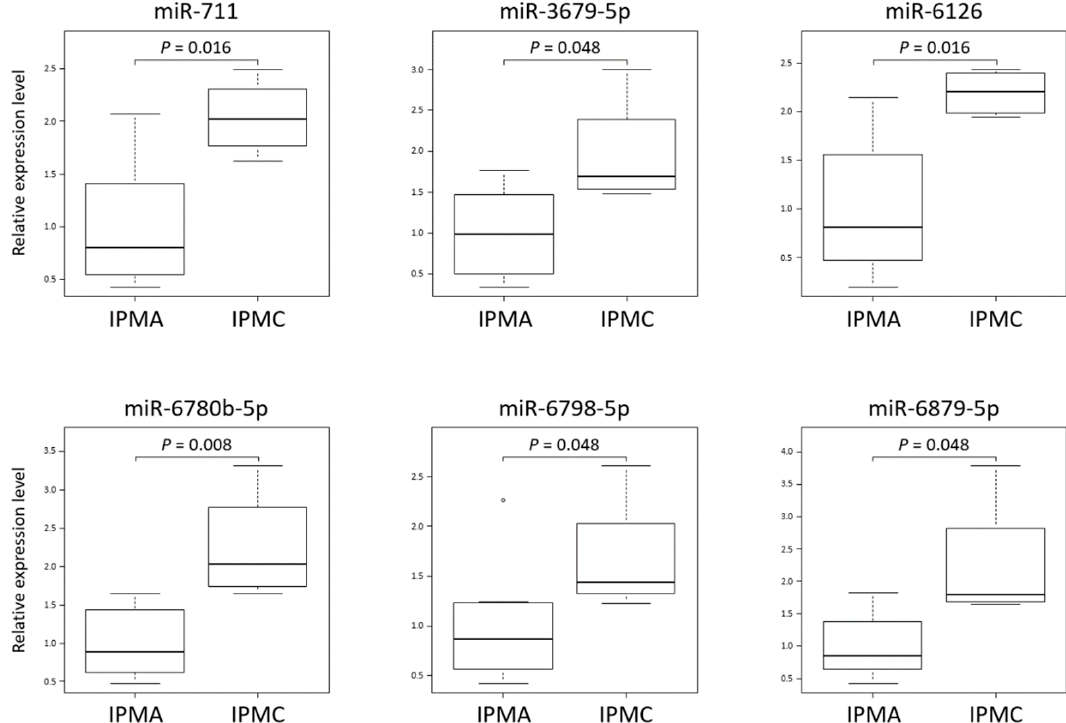
Figure 2. Comprehensive analysis of miRNA expression in cyst fluid of IPMN and comparing IPMA with IPMC. RNA was extracted from IPMN cyst fluid and labeled. Then, RNAs were hybridized and fluorescent signals were scanned as described in Materials and Methods. A relative expression level of a given miRNA was calculated by comparing the signal intensities of the valid spots. The data were normalized by the expression levels of miRNA in IPMA cyst fluid. Among the targeting 2565 genes, indicated six in cyst fluid from IPMC were significantly higher level than those in IPMA. The data were analyzed by Mann–Whitney U test. Data are expressed as box-and-whisker plots. Within the boxes, the center lines denote the median values and boxes extend from the 25th to the 75th percentile of each group’s distribution of values. Vertical extending lines mean adjacent values, i.e., the most extreme values within 1.5 interquartile range of the 25th and 75th percentile of each group, and the value beyond the upper and lower bounds is considered an outlier marked with a white dot. A p -value < 0.05 considered a significant difference between the groups. IPMA, intraductal papillary mucinous adenoma; IPMC, intraductal papillary mucinous